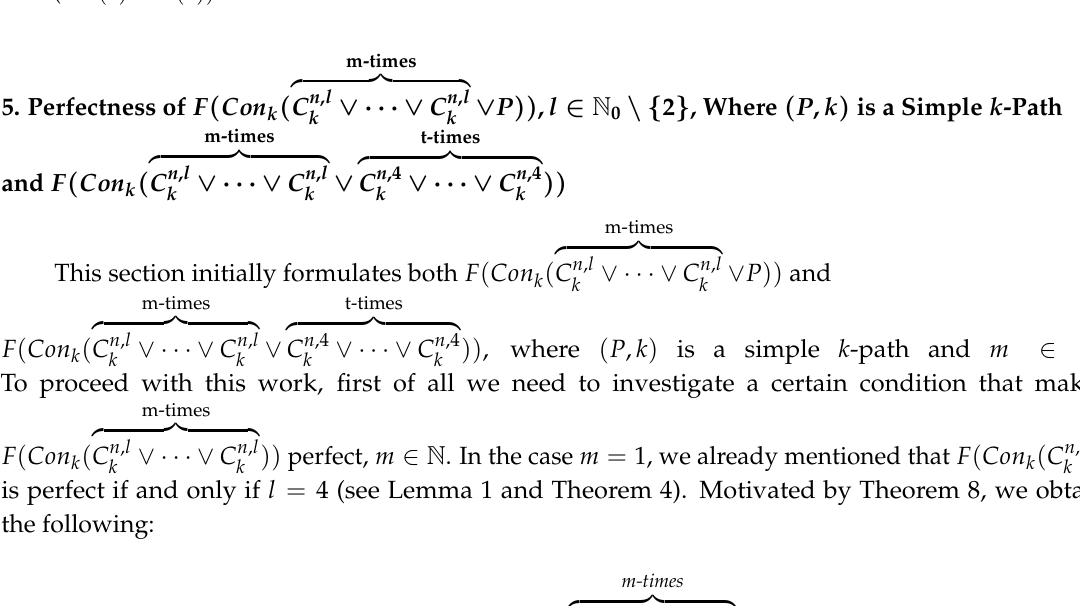
Figure 4. Explanation of the process of obtaining the numbers m ∈ [ 1,7 ] Z ⊂ F ( Con 26 ( C 3,6 )) (see (20)–(26). Establishment of a simple 26-path from the given digital wedge C 3,6 C 3,6 26 (see ( a ) → ( b ))